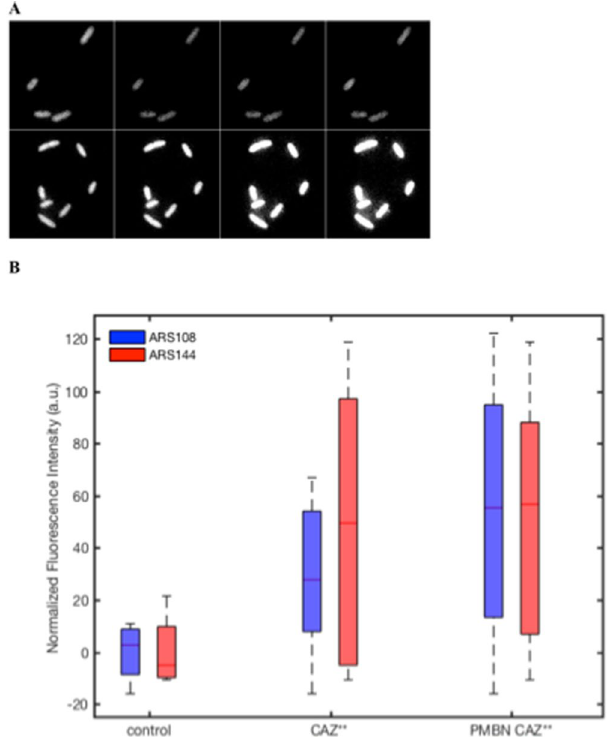
Figure 5. CAZ ** accumulation in individual bacterial cell containing porins. ( A ) Images acquired on DUV microscope. The images showed ARS144 alone (upper panel), ARS144 with CAZ ** (lower panel) at 6, 12 18 and 24 min incubation respectively. ( B ) CAZ ** accumulation measured at 24 min incubation. The 6-MeOQ fluorescence obtained during incubation with the two strains ARS108 (blue) and ARS144 (red) was indicated. The data were corrected by the tryptophan signal and with controls (without CAZ ** ). PMBN: final concentration 102.4 mg/L. The boxplot corresponded to measurements carried out with about 20